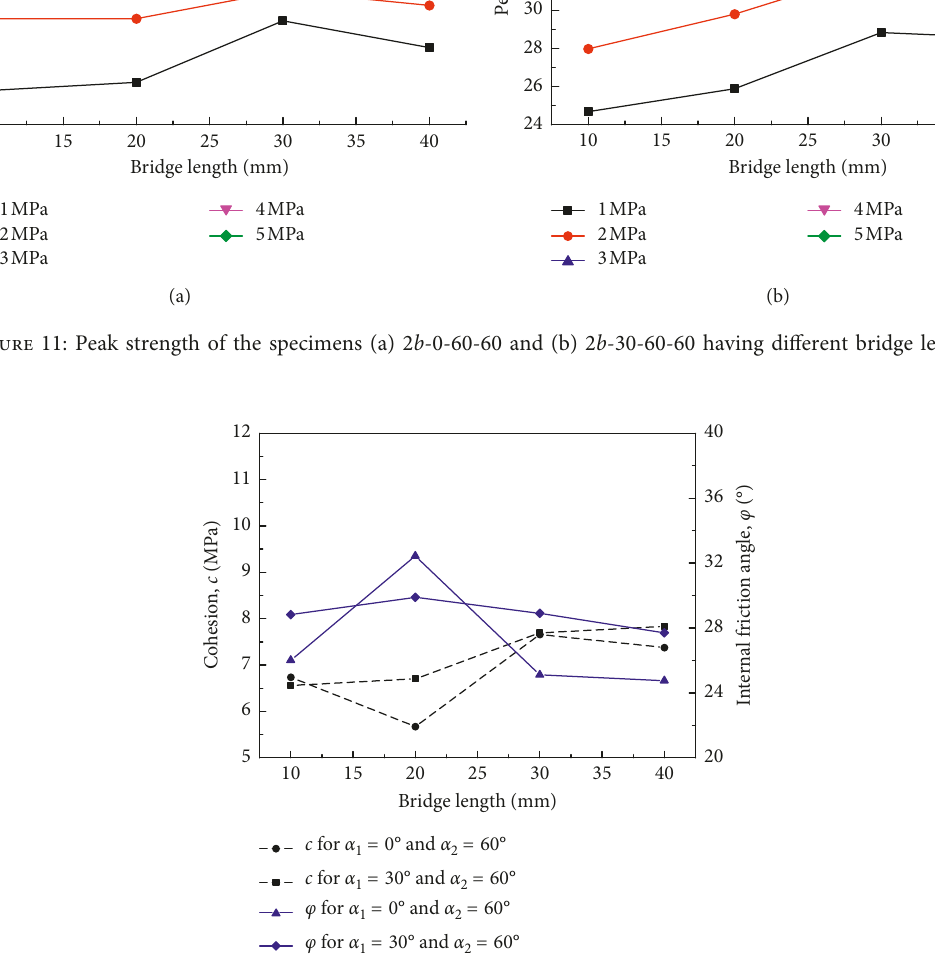
Figure 12: Shear parameters of the specimens 2 b -0-60-60 and 2 b -30-60-60 having different bridge